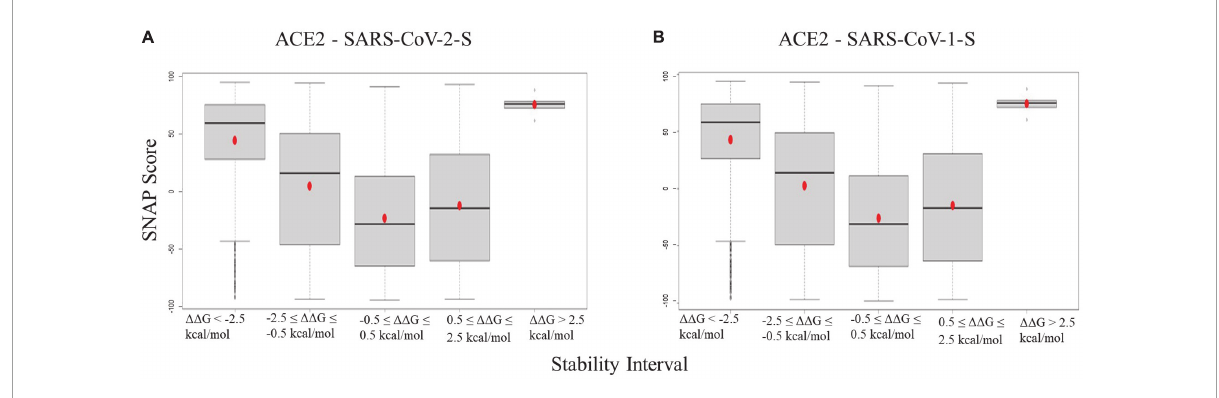
FIGURE3 Boxplots for the SNAP scores of ACE2 mutation groups with different folding energy change intervals in panel (A) ACE2 - SARS-CoV-2 and (B) ACE2 - SARS-CoV-1 complexes.